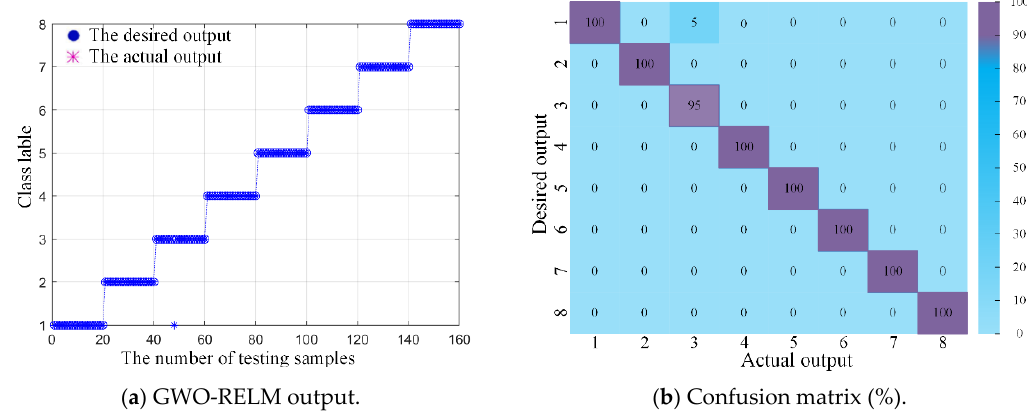
Figure 12. Identification results of the proposed method.